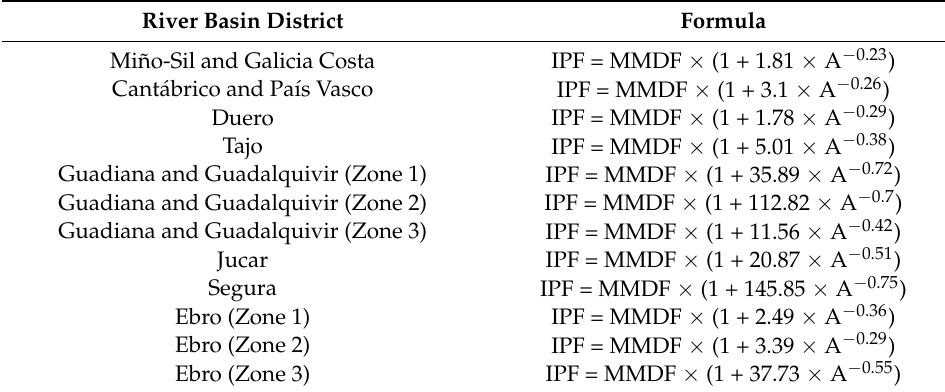
Table 2. Regional formulas of CEDEX